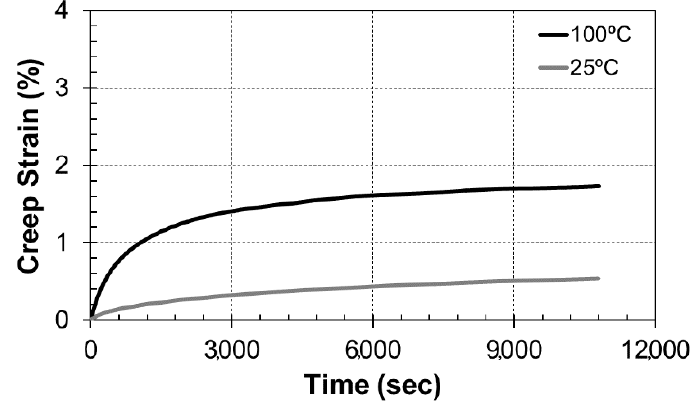
Figure 15. Creep strain as a function of time for a nanocomposite made of 15 v% cellulose and 0 wt. % STO nanoparticles.